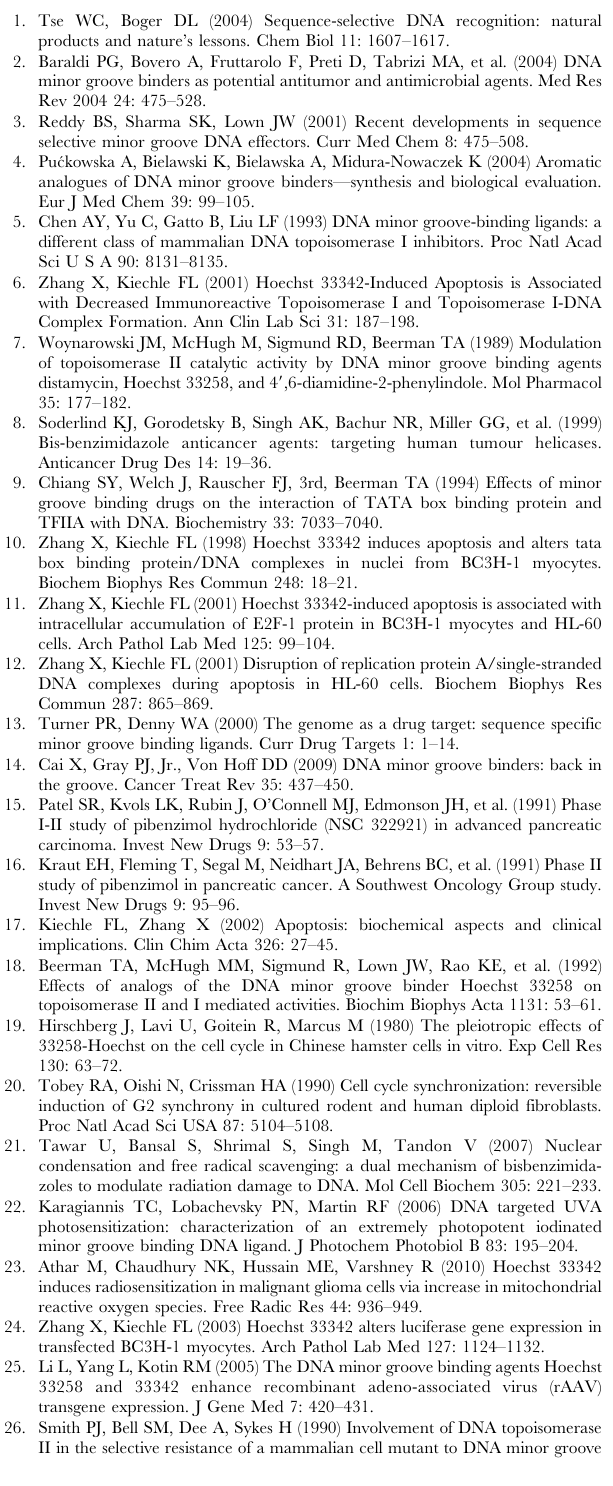
Table S1 Primer sequences used for real-time RT-PCR in microarray validation